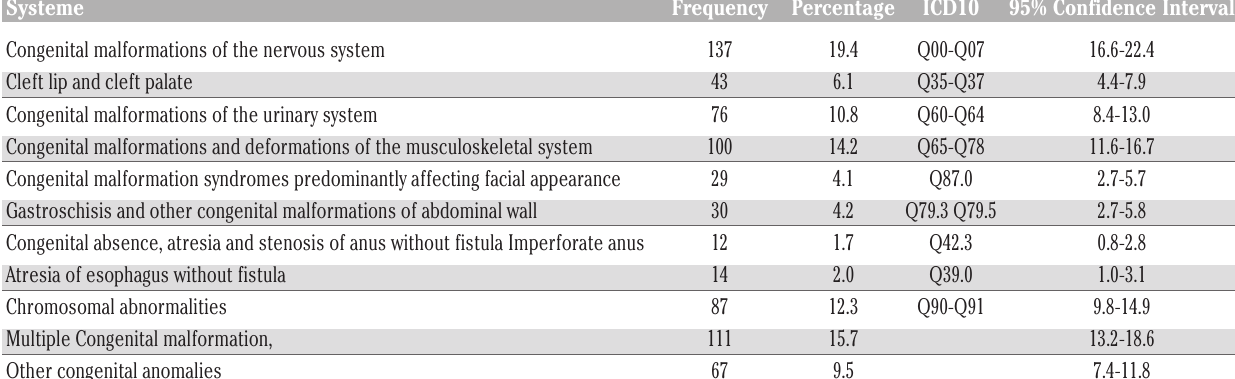
Table 2. Classifications of congenital malformations according to